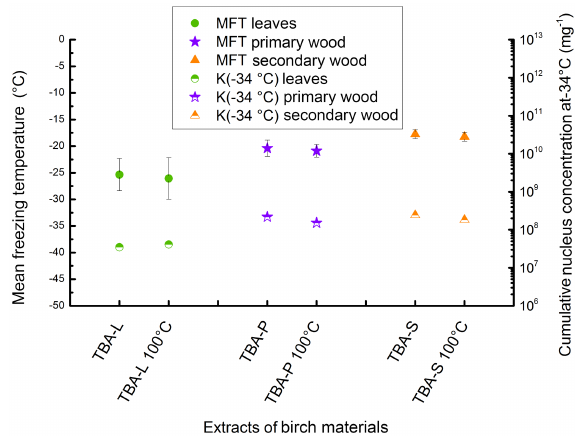
Figure 6. Results of the heat treatment of the different TBA ex- tracts. Leaves are marked with green circles, primary wood with vi- olet stars, and secondary wood with orange triangles. The left value belongs to the untreated sample, the right value to the sample treated with 100 ◦ C for 1h. Filled symbols represent the mean freezing temperature and correlate with the left y axis; half-filled symbols represent the cumulative nucleus concentration as − 34 ◦ Cmg − 1 extracted sample and correlate with the right y